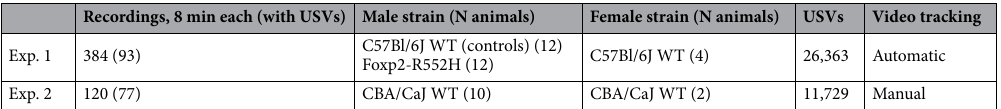
Table 1. Overview of the properties of the two experiments conducted, regarding the strain differences, number of recordings, type of video tracking and collected USVs.